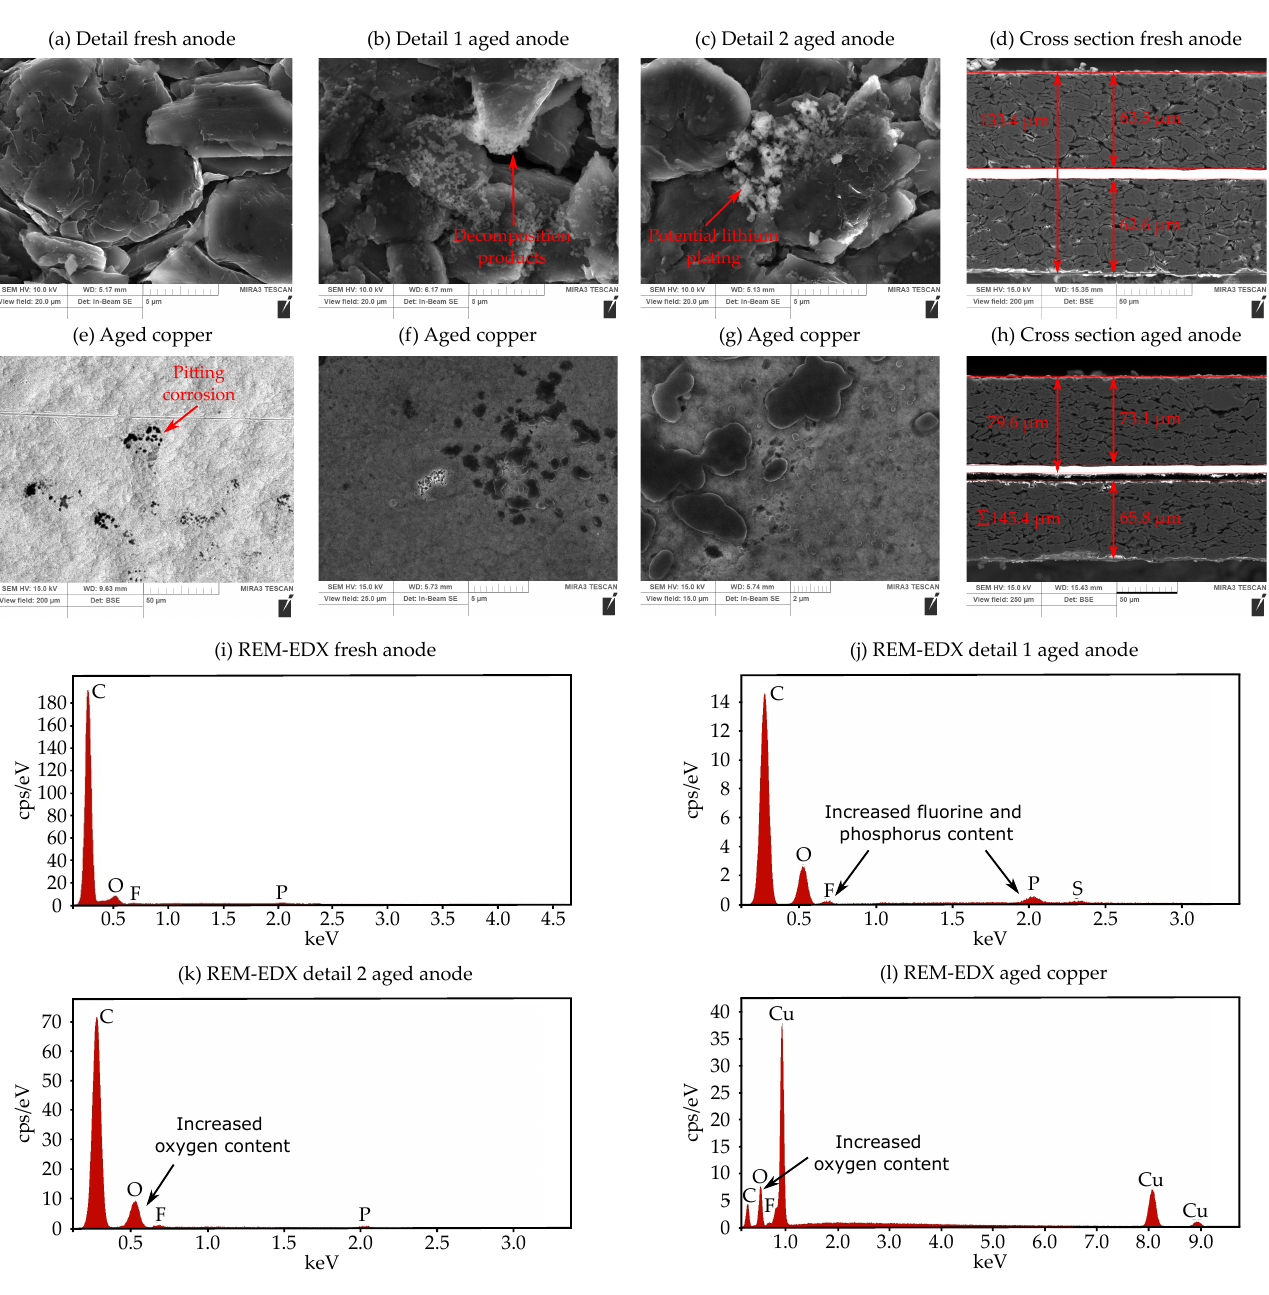
Figure 4. Analyzing the electrical aging mechanisms at the anode of the investigated lithium-ion cell with SEM-EDX: ( a ) Surface image of the fresh anode. ( b ) First conspicous detail of the aged anode showing decomposition products. ( c ) Second conspicous detail of the aged anode indicating lithium-plating. ( d ) Cross section image and thickness measurement of the fresh anode. ( e – g ) Surface images of the aged copper current collector with pitting corrosion effects. ( h ) Cross section image and thickness measurement of the aged anode. ( i ) SEM-EDX analysis of the fresh graphite anode. ( j , k ) SEM-EDX analysis of the first and second conspicous spot of the aged anode. ( l ) SEM-EDX analysis of the aged copper current